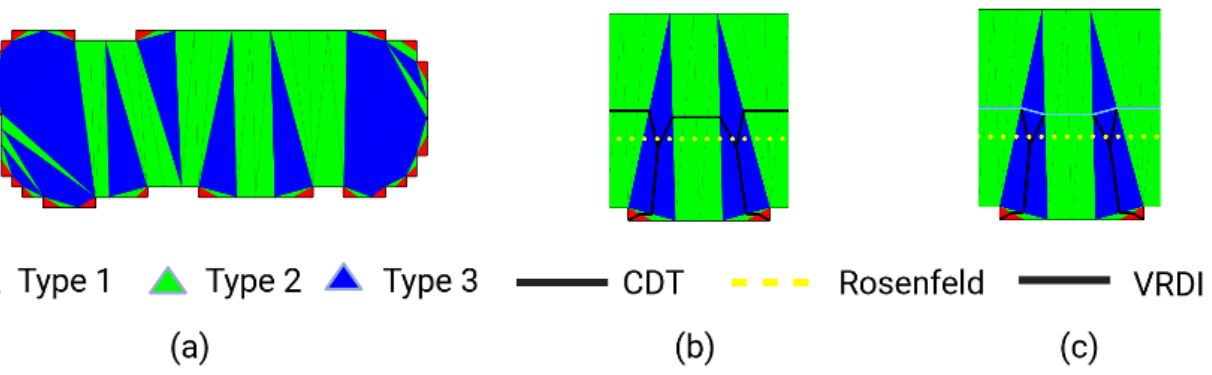
Figure 9. Three type three triangles without endpoints, corners, or intersections. ( a ) Delaunay triangles classification results; ( b ) Overlay of Rosenfeld and CDT results; ( c ) Overlay of Rosenfeld, CDT and VRDI results.